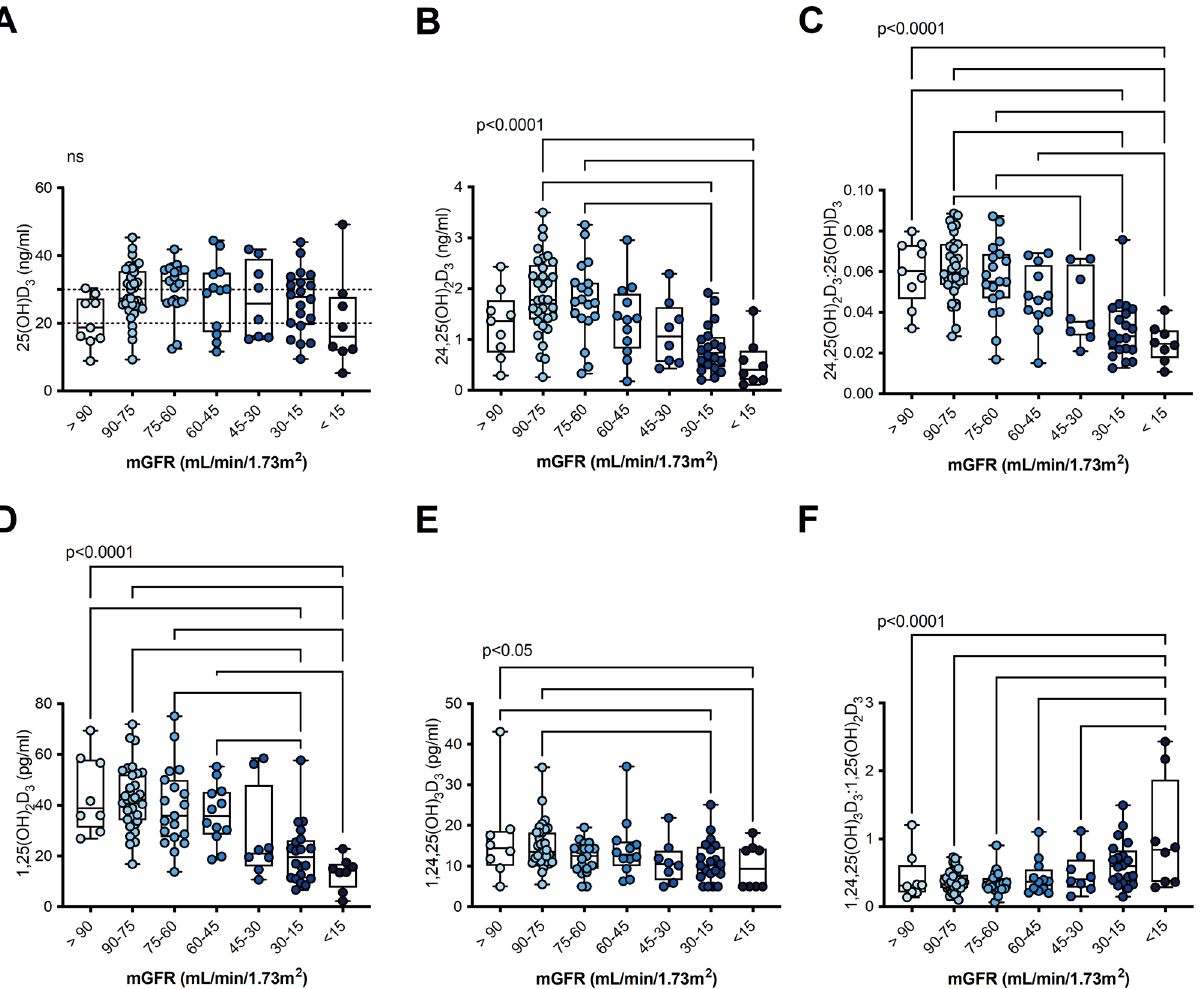
Figure 1. Vitamin D metabolites and 24-hydroxylation ratios in participants delineated by GFR measured by iohexol/inulin clearance. ( A ) 25(OH)D 3 , ( B ) 24,25(OH) 2 D 3 , ( C ) 25-VMR 24,25(OH) 2 D 3 :25(OH)D 3 , ( D ) 1,25(OH) 2 D 3 , ( E ) 1,24,25(OH) 3 D 3 , ( F ) 1,25-VMR 1,24,25(OH) 3 D 3 :1,25(OH) 2 D 3 . Dotted lines on ( A ) indicate cut offs for insufficiency and deficiency. One-way ANOVA with post hoc test for linear trend between mGFR categories, if mGFR categories were a significant source of variation, pairwise comparisons were performed with Fishers LSD test for ( A – F ). *p < 0.05, **p < 0.01, ***p < 0.001, ****p < 0.0001. Box plot indicates medial, IQR and range. Participants reporting cholecalcierfol use excluded from graphs and analysis (> 90 N = 109; 90–75 N = 33; 75–60 N = 19; 60–45 N = 12; 45–30 N = 8; 30–15 N = 20; < 15 N =